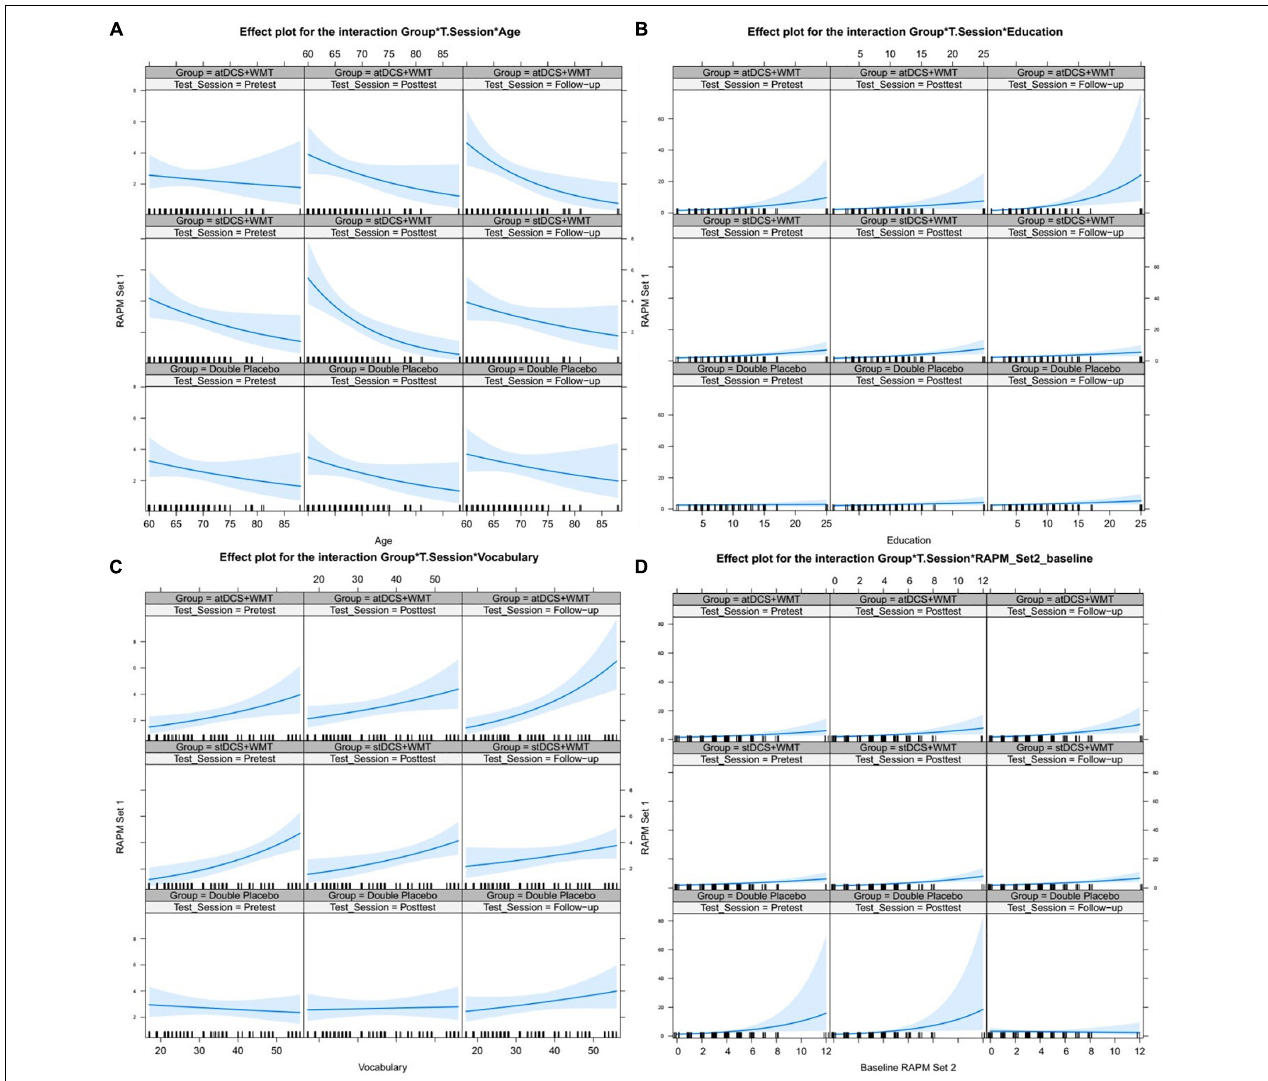
FIGURE 4 | Fitted values (Group × Testing Session × Predictor) for each predictor in RAPM_set 1 scores. Predictors: age (A) ; education (B) ; vocabulary (C) ; baseline RAPM_set 2 (D) . The shaded area is a pointwise 95% confidence band for the fitted values, based on standard errors and computed from the covariance matrix of the fitted regression coefficients using Conway-Maxwell-Poisson